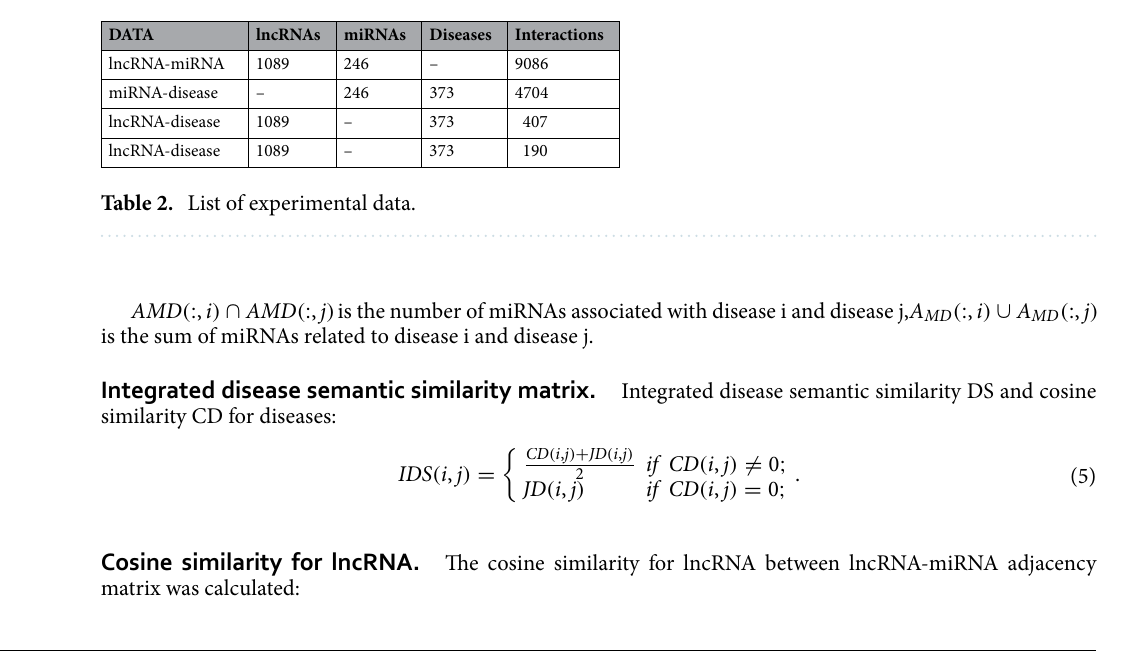
Figure 4. Flow chart of LFMP Applied to lncRNA-disease association prediction.